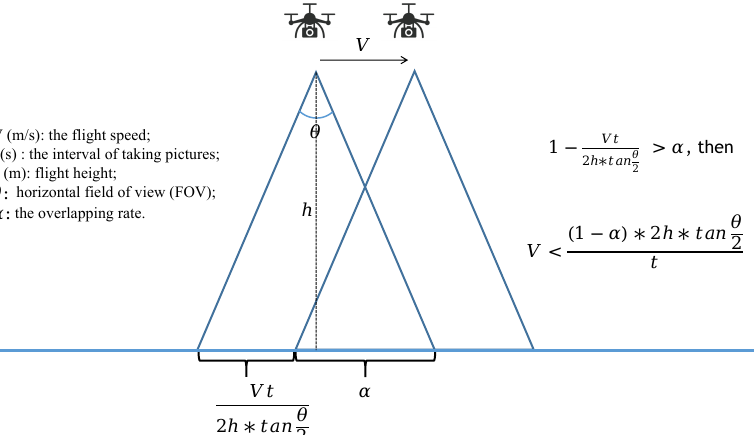
Figure 3. The relationship among the following significant parameters: flight speed is V (m/s), flight height is h (m), horizontal field of view (FOV) is θ , the overlapping rate is α , the interval of taking pictures is t (s). In order to guarantee the overlapping rate, the above-mentioned parameters should meet the equation shown in the figure.